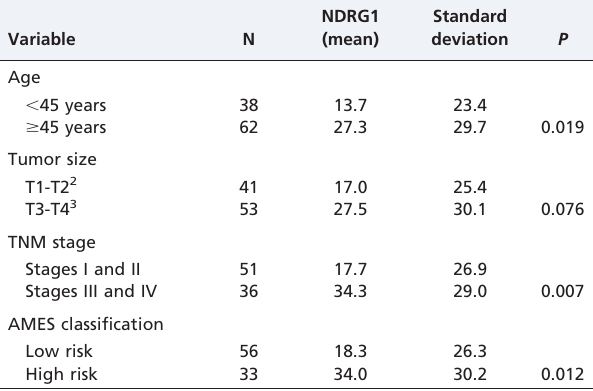
Table 2 - NDRG1 protein expression and clinical- pathological variables in patients with thyroid carcinoma 1